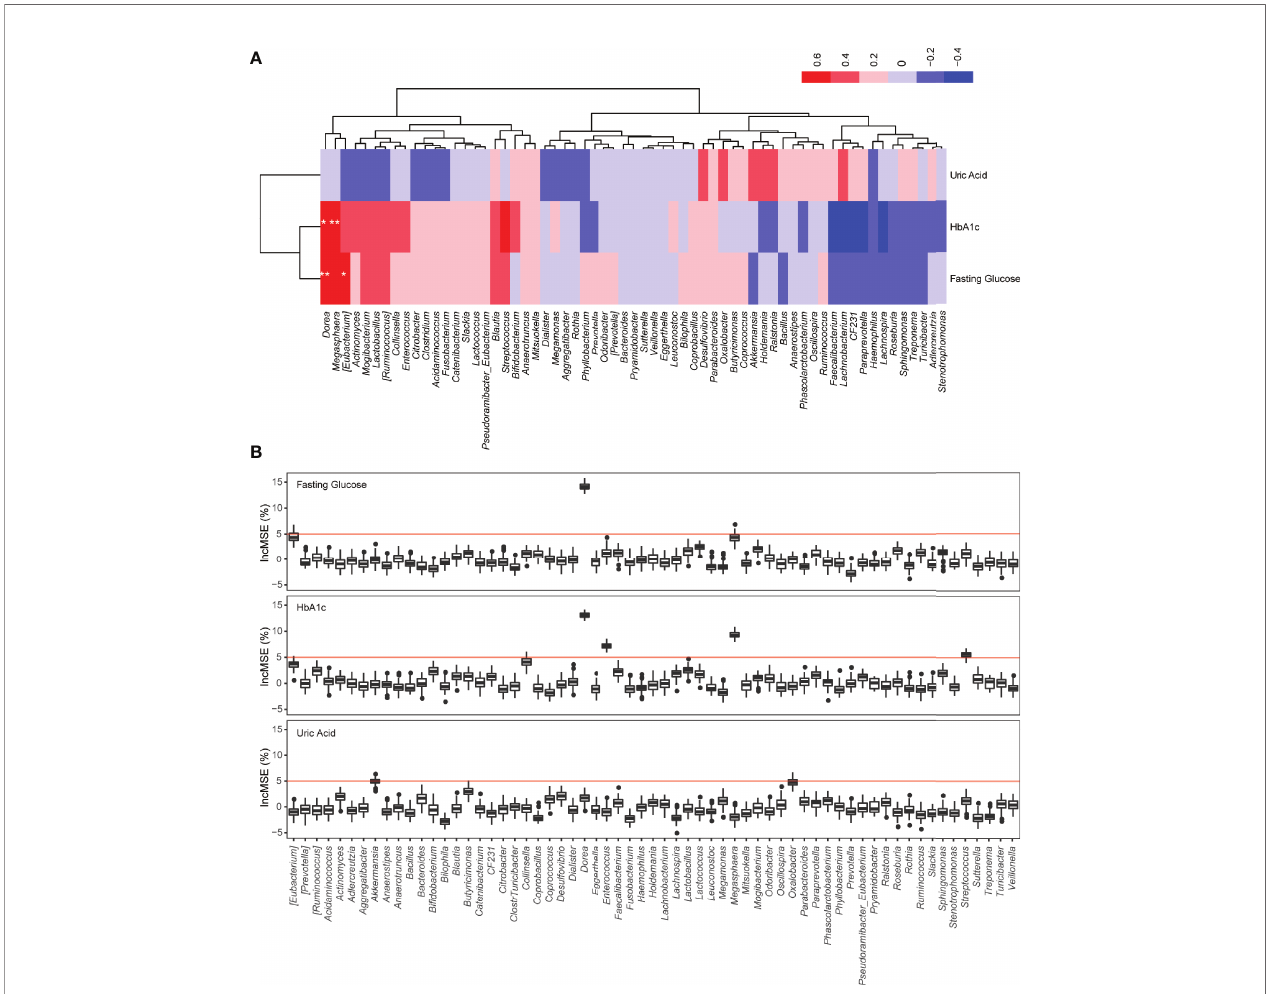
FIGURE 2 | The relationship between the genus-level microbial abundance and clinical factors. (A) Heatmap of the Spearman ’ s correlation coef fi cients between the abundance of genera and clinical factors using both T2DM and control samples. *p < 0.05; **p < 0.01. (B) Random forest analysis to assess the association between microbial abundance at the genus level and clinical factor. Signi fi cant level is indicated in red line (p <